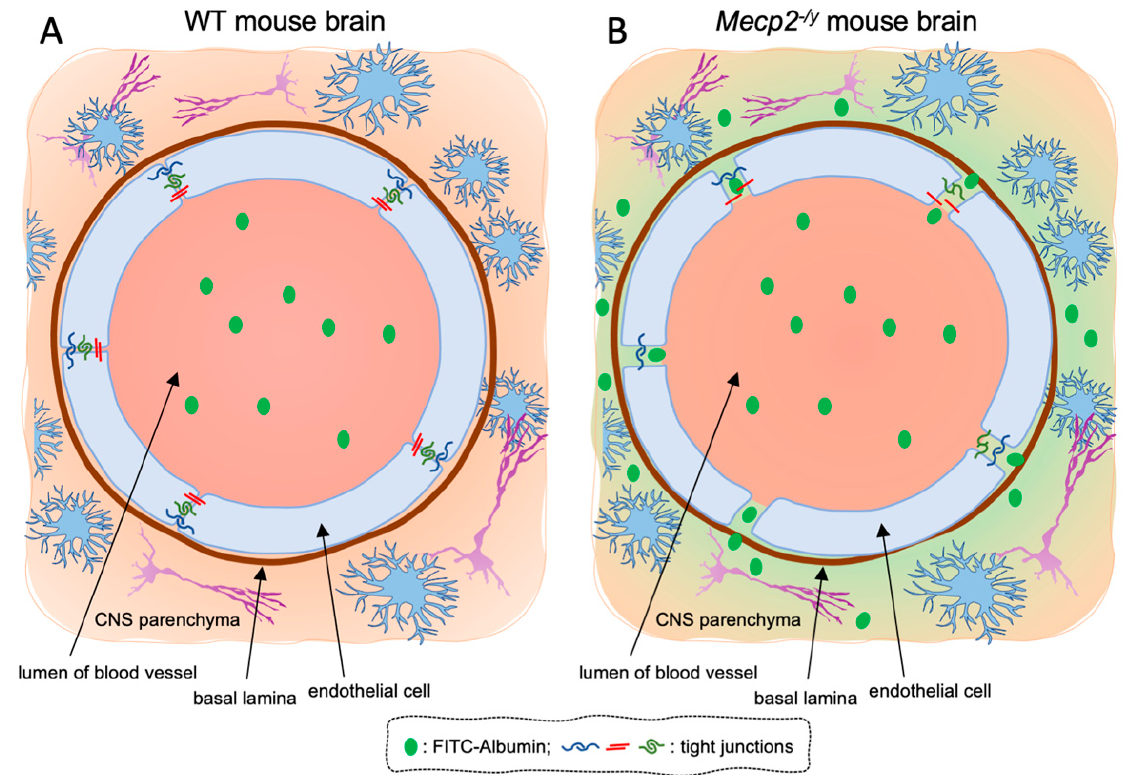
Figure 6. Schematic representation of the blood–brain barrier in WT and Mecp2 -/y mice. ( A ) In WT brain, the tracer FITC-albumin is retained within the lumen of blood vessels due to the integrity of the TJs between the endothelial cells in the brain parenchyma. ( B ) In Mecp2 -/y brain, an increased permeability of the BBB, visible as a diffusion of FITC-albumin along perivascular spaces and brain parenchyma, occurs (likely due to disruption of the TJs).